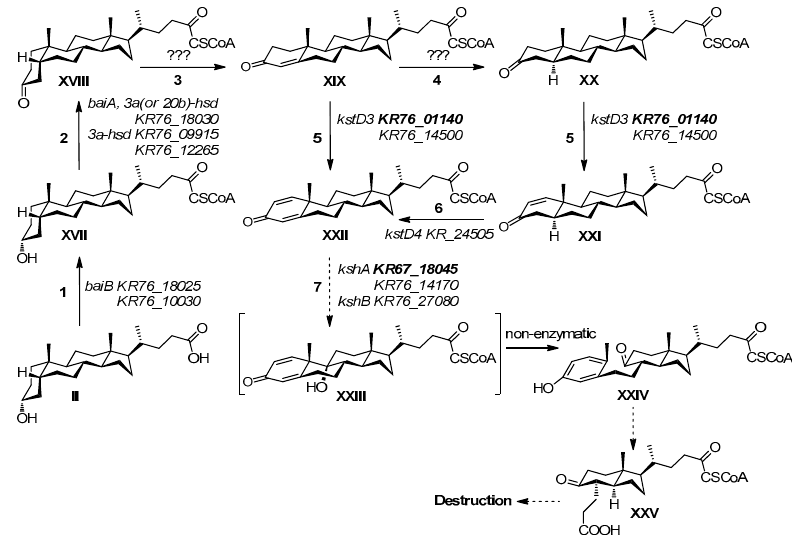
Figure 7. Scheme of the lithocholic acid bioconversion by N. simplex VKM Ac-2033D. Substances: II -Lithocholic acid, XVII -Lithocholanoyl-CoA, XVIII -3-Oxo-5 β -cholan-24-oyl-CoA, XIX -3-Oxo-chol-4-en-24-oyl-CoA, X -3-Oxo-5 α -cholan-24-oyl-CoA, XXII -3-Oxo-chola-1,4-dien-24-oyl-CoA, XXIII XXIV - 3-Hydroxy-9-oxo-9,10-seco-chola-1,3,5(10)-trien-24-oyl-CoA, XXV - 4 α -(2-Carboxyethyl)-5-oxo-7a β , γ -dimethyl-3a α -hexahydroindane-1 β -butyroyl-CoA. Biochemical